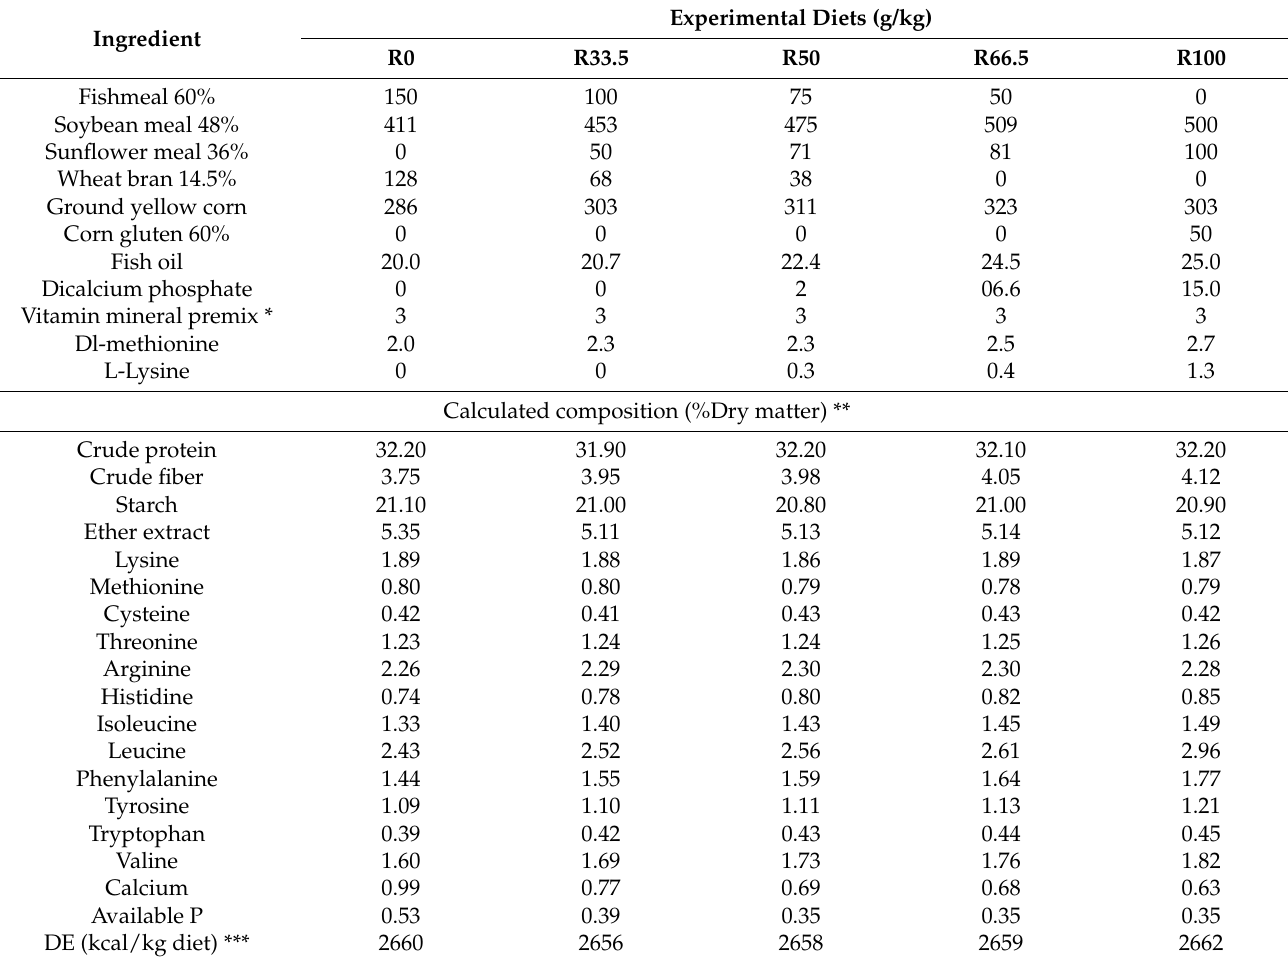
Table 1. Ingredient composition and calculated nutrient content values of the experimental diets (% dry